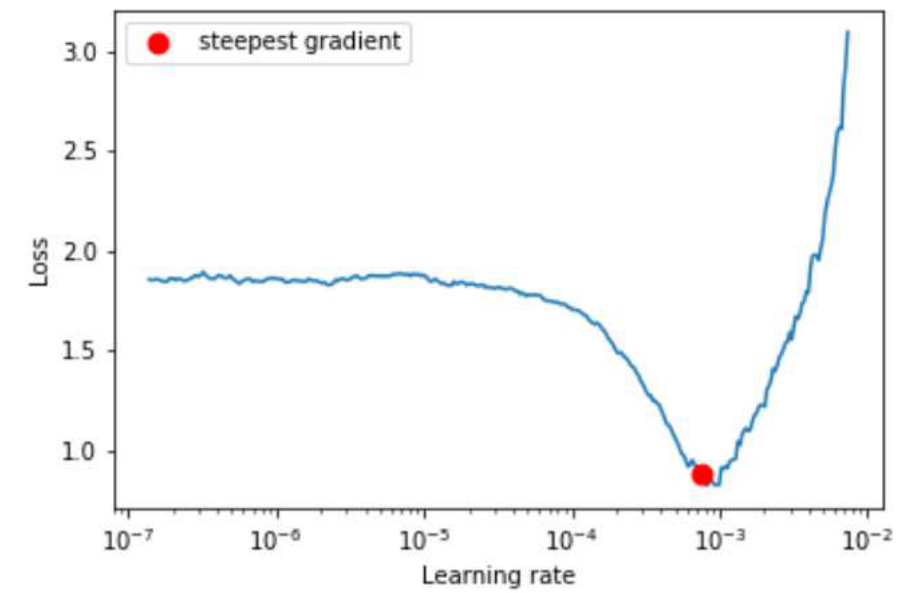
Figure 9. The loss decreases in the beginning, then the training process starts diverging. It shows the recommended the optimum learning rate for the current training.